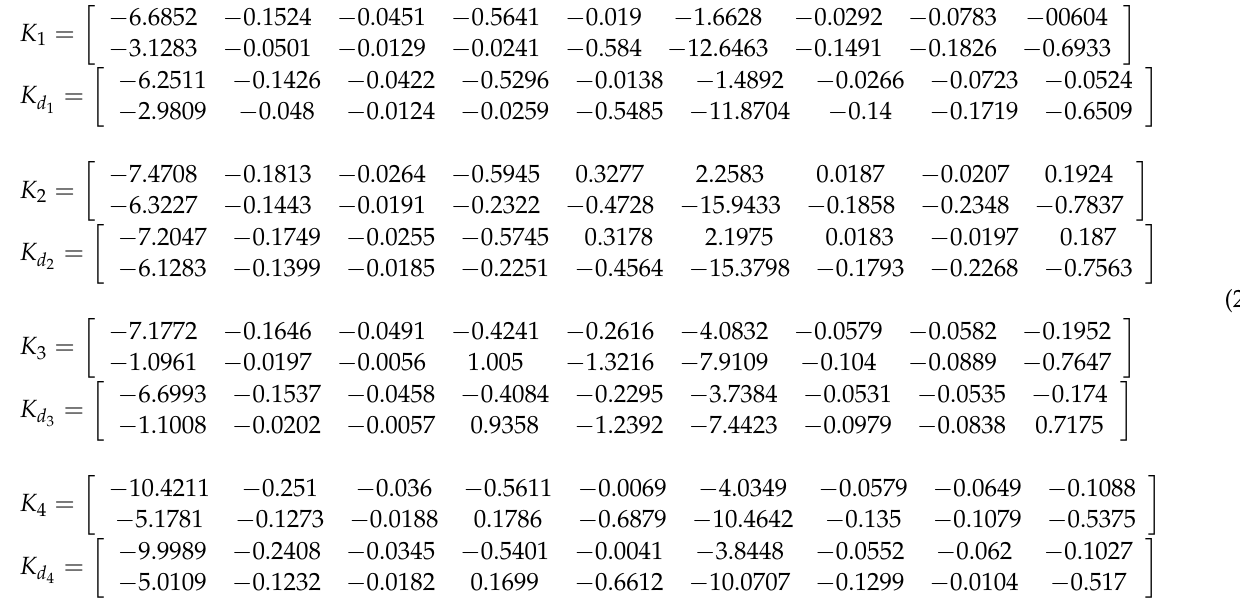
Figure 6. Deviation in mechanical power of the proposed LFC controller for unit step load disturb- ance. In another scenario, the random load demand change illustrated in Figure 9 is en- tered into both areas. The frequency, mechanical power, and tie-line power deviations of the closed-loop LFC system using the presented control structure step load disturbance randomly are shown in Figures 10–12, respectively. Moreover, the control signals are shown in Figure 13. The results prove that the presented scheme could efficiently fulfill performance criteria, such as fast transient responses, load disturbance rejection, and ro- bustness by considering all practical limitations.